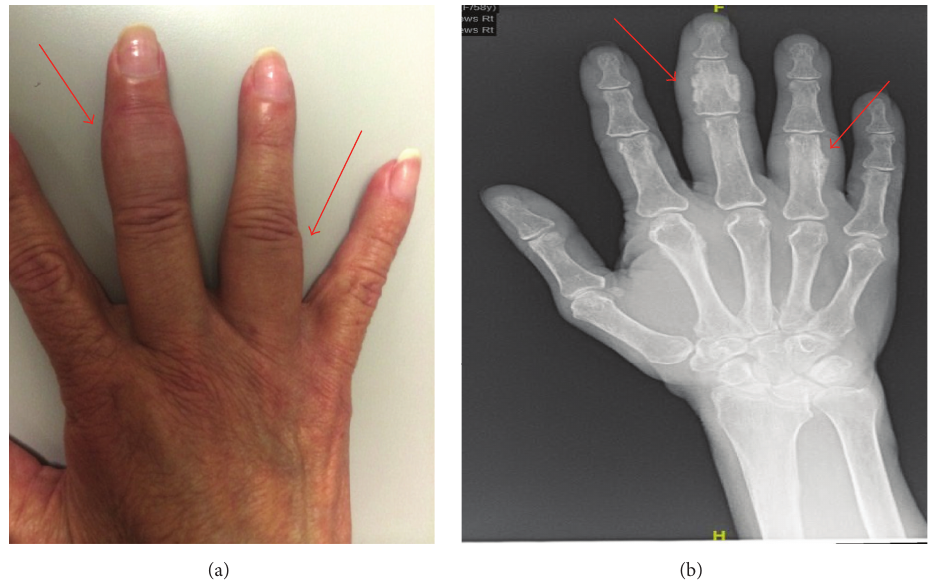
Figure 1: Examination findings and radiograph illustrating periostitis of the right hand. (a) Examination revealed swelling with tenderness of the third middle phalange as well as the less marked swelling of the fourth proximal phalange. (b) Radiograph showed multifocal periosteal reaction with associated soft tissue